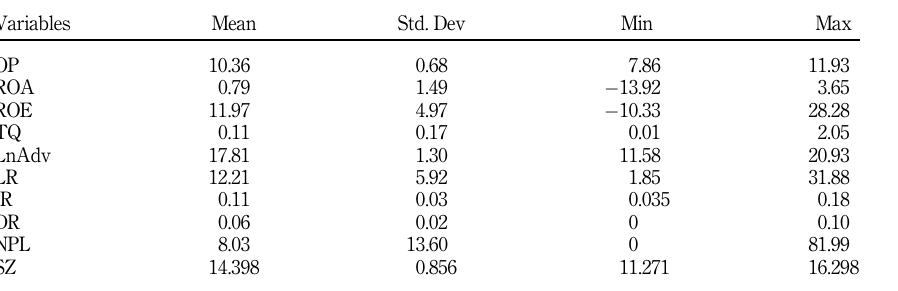
Table 1. Summary statistics